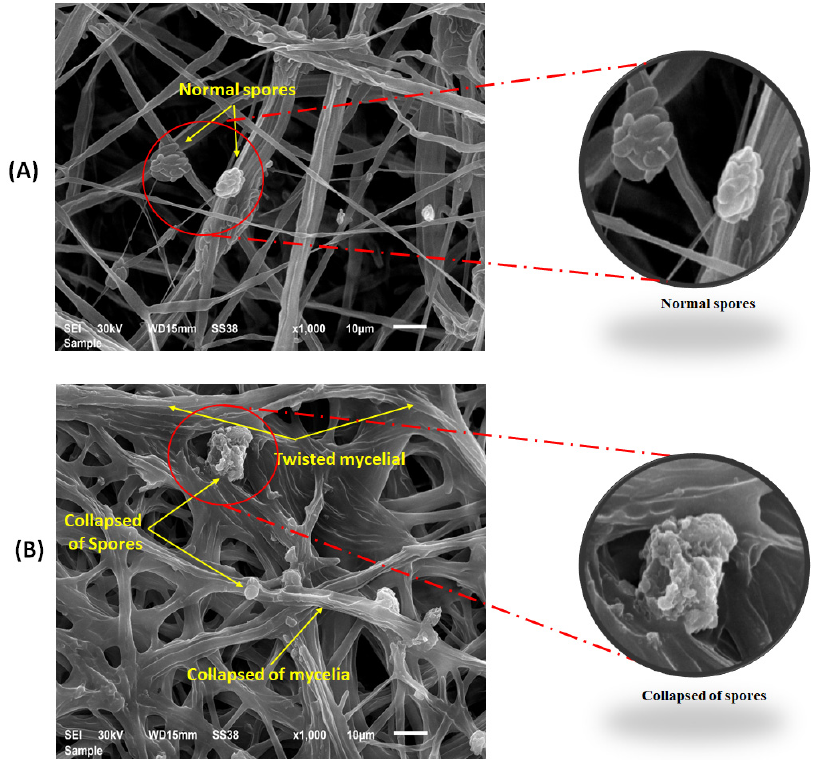
Figure 6. Scanning electron microscope observations of spores and mycelia of F. solani taken from growth medium on potato dextrose agar, with two sizes of nano copper showing. ( A ): Untreated control with normal spores and mycelium (yellow arrows). ( B ): Treated with Cu 2 ONPs, showing collapsed mycelia and spores (yellow arrows).